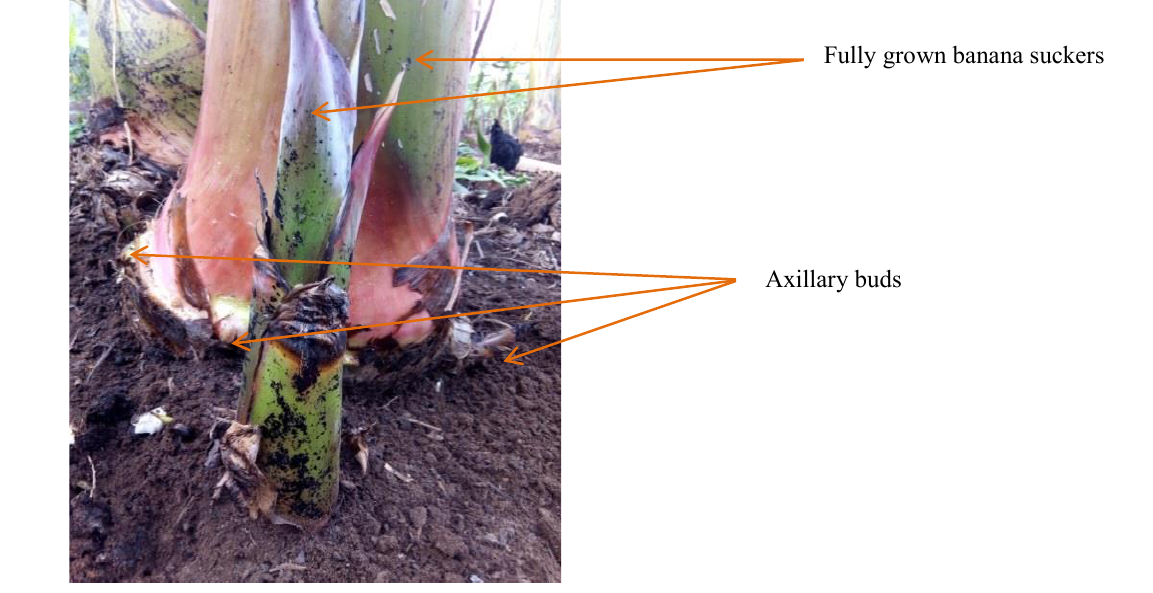
Figure 1: Axillary buds and a fully developed sucker emerging from the banana